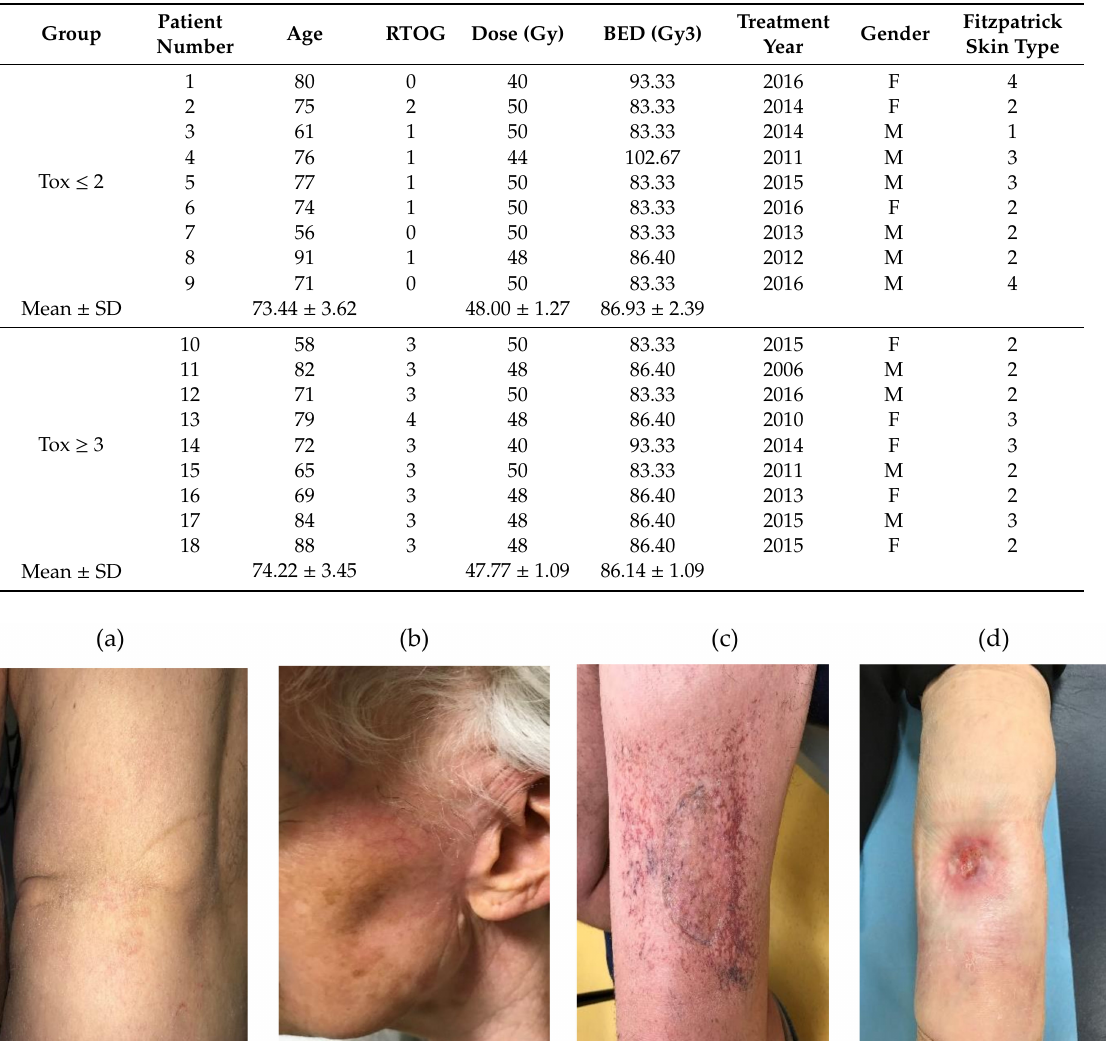
Table 1. Characteristics of the cohort depending on the toxicity group. Age, RTOG (Radiation Therapy Oncology Group) / EORTC (European Organization for Research and Treatment of Cancer) grade of late skin toxicity, total received dose, BED (Biological E ff ective dose) with α / β = 3, treatment year, gender and Fitzpatrick skin type are reported here. Groups Tox ≤ 2 and Tox ≥ 3 correspond to patients presenting grade 2 or less and grade 3 or more of late skin reactions after RT according to RTOG / EORTC, respectively.